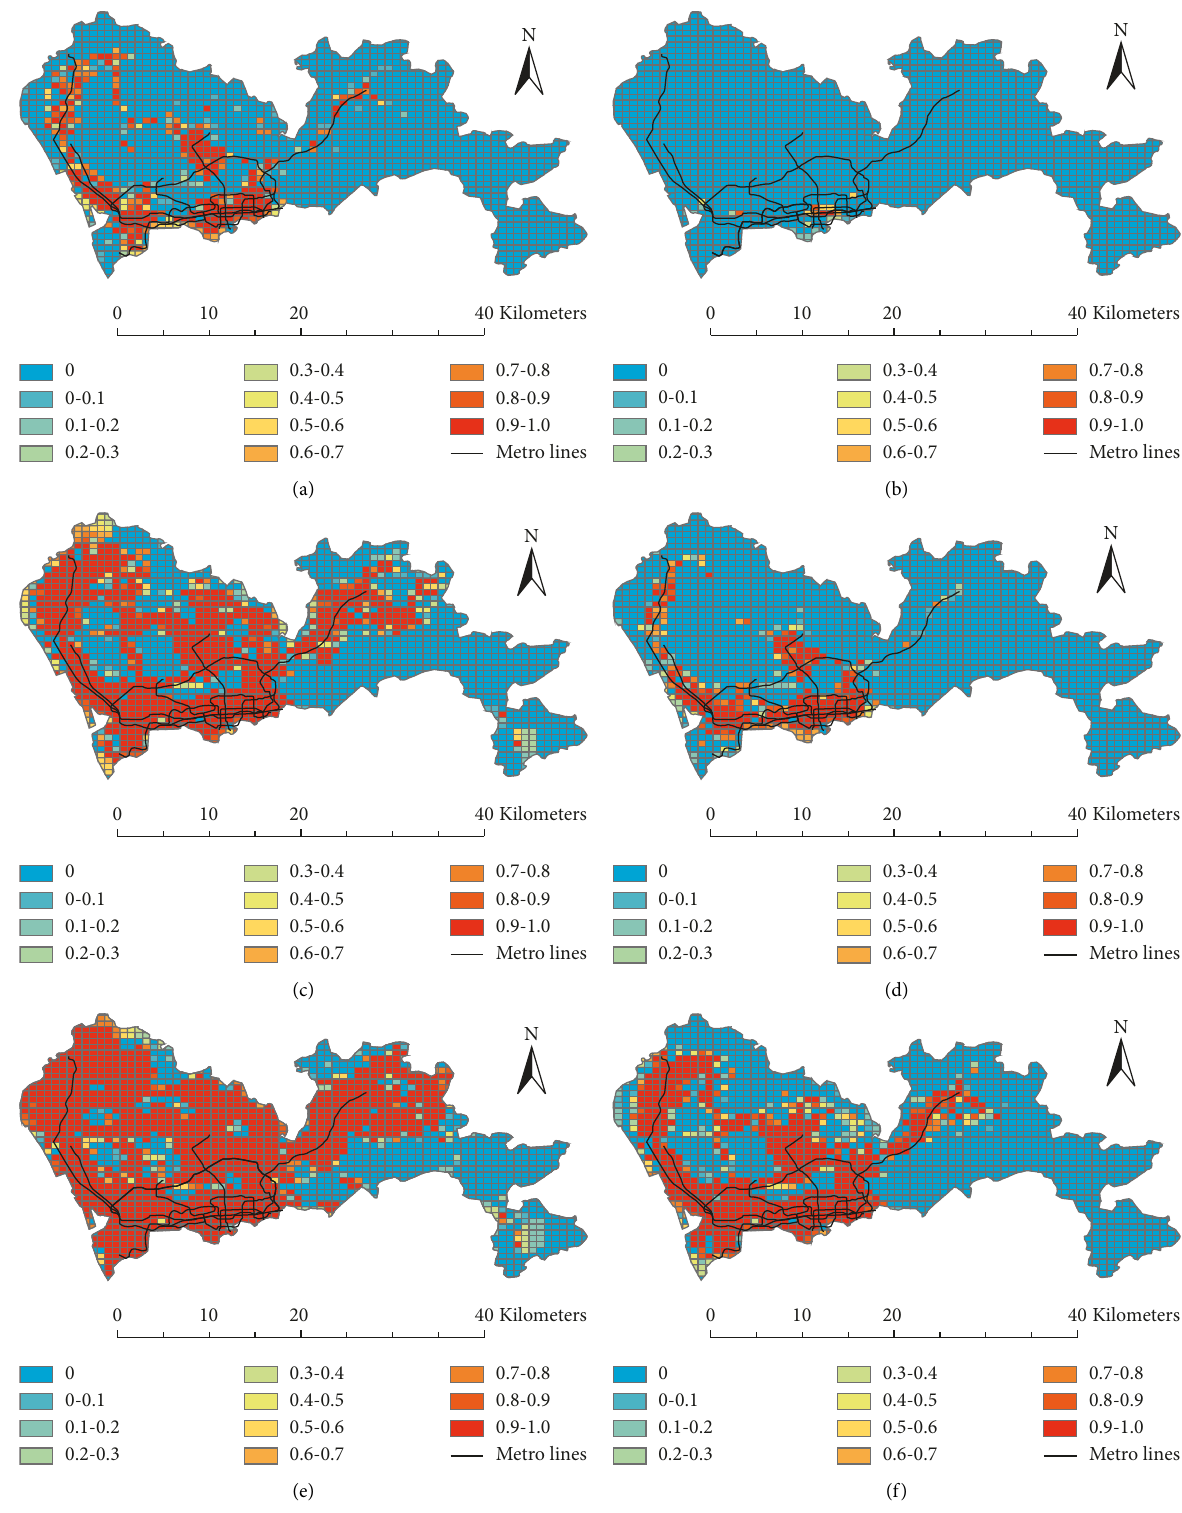
Figure 4: Reliability of